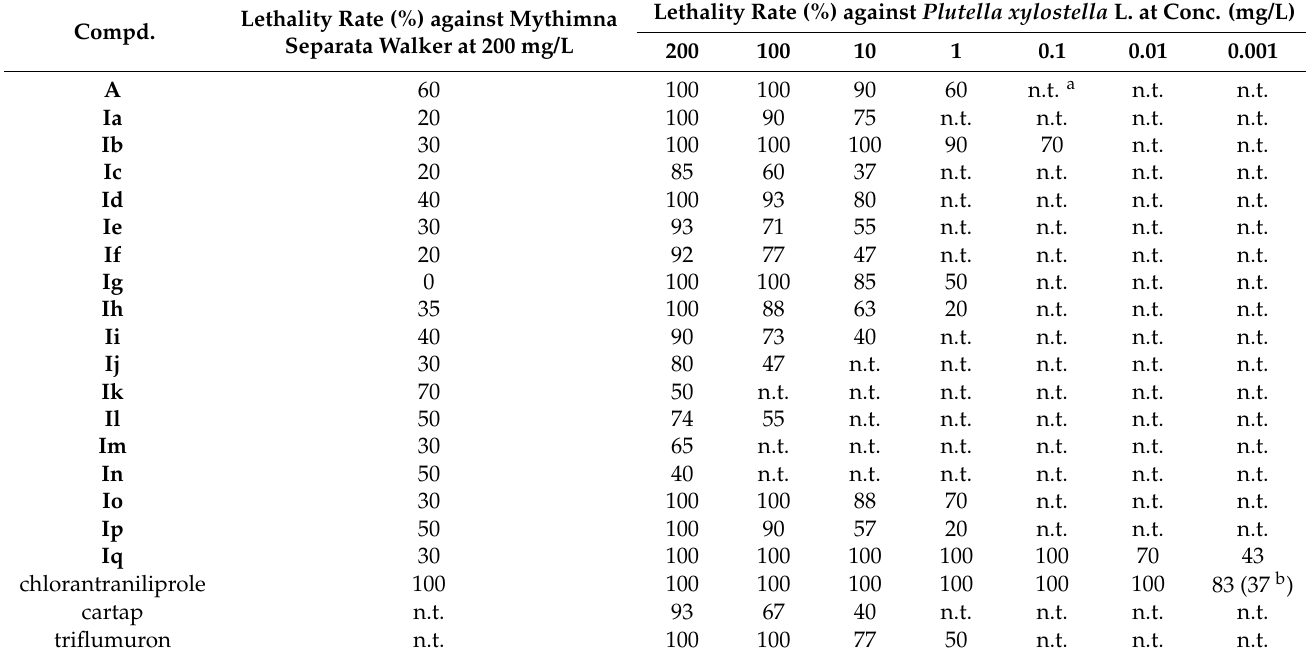
Table 1. Insecticidal activities of the target compounds A and Ia–q .